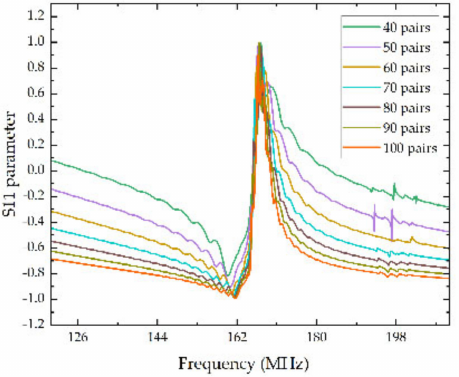
Figure 4. S11 parameters curves of IDTs with different